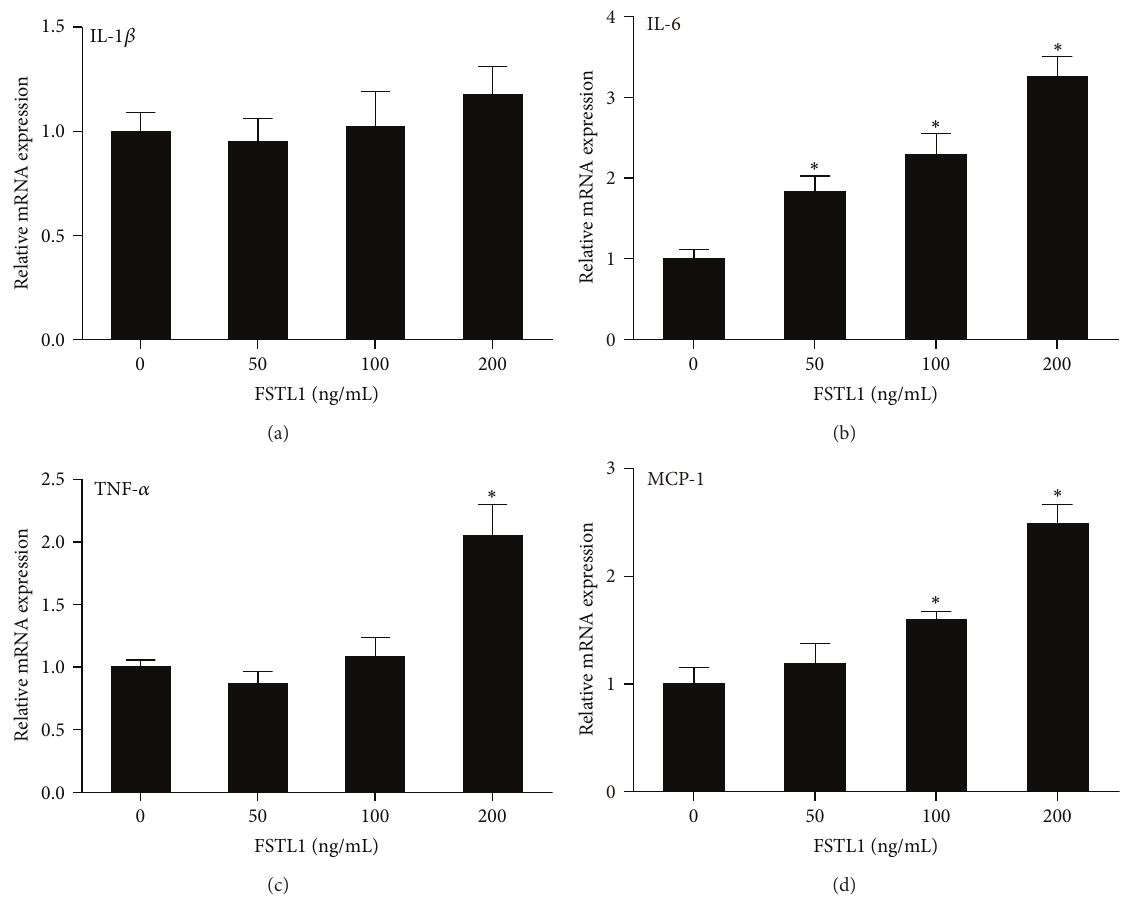
Figure 5: FSTL1 induces the expression of proinflammatory mediators in RAW264.7 macrophages. RAW264.7 macrophages were treated with increasing dose of recombinant mouse FSTL1 (0, 50, 100, and 200 ng/mL) for 24 h. mRNA expressions of IL1- 𝛽 (a), IL-6 (b), TNF- 𝛼 (c), and MCP-1 (d) were evaluated by quantitative RT-PCR. Relative gene expression levels were normalized to 𝛽 -actin and expressed as fold of control. Data are mean ± SE; 𝑛 = 3 . ∗ 𝑃 < 0.05 versus